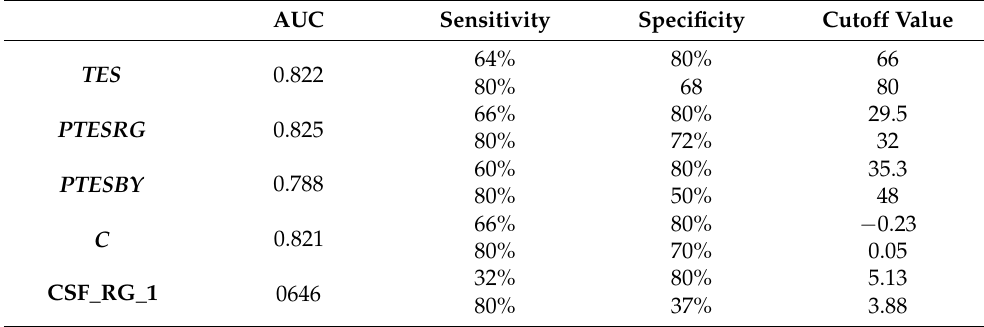
Table 4. Extracted parameters from the ROC curves: area under the curves (AUC), sensitivity at 80% specificity, specificity at 80% sensitivity, and their respective cutoff